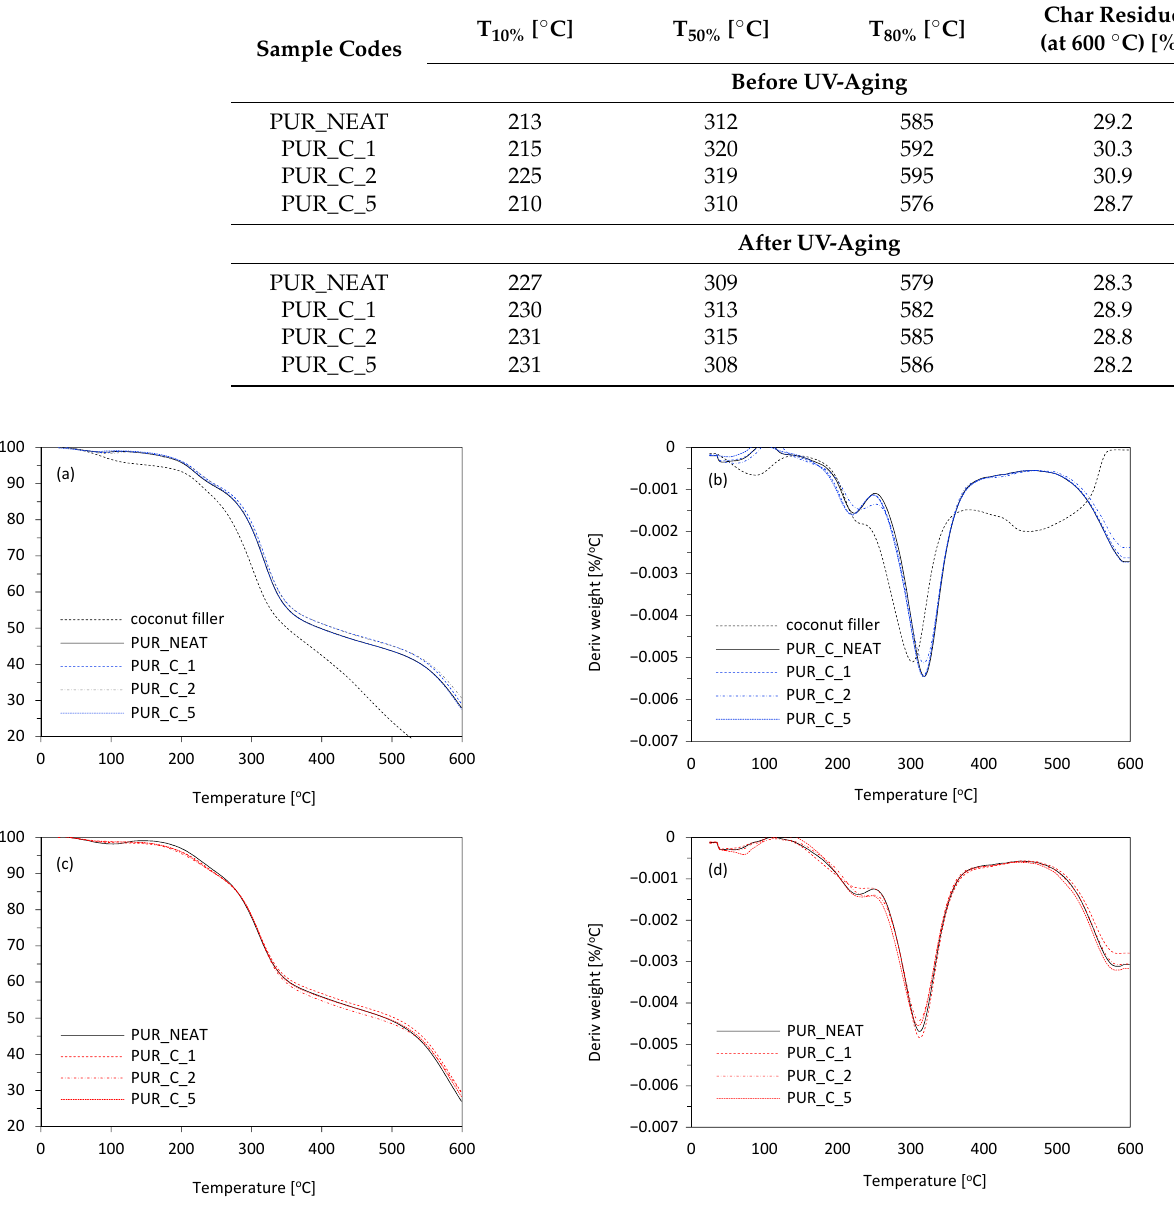
Figure 13. TGA results for PUR composites measured ( a , b ) before, and ( c , d ) after the UV-aging. In all cases, a three-stage decomposition of the PUR composites was observed. The first stage of decomposition (T max1 ) occurred in the range of 200–230 °C and referred to the moisture absorption of cellulosic filler [57–60] and decomposition of the urethane bond [57,58]. The second stage (T max2 ) of the PUR-composite decomposition occurred in the range of 300–350 °C, and should be assigned to the thermal pyrolysis of hard segments of PUR, which resulted in the formation of alcohol and isocyanate groups [61–63]. When compared with PUR_NEAT, T max2 increased on the addition of 1 and 2 wt % of coir-fiber filler—the value of T max2 increased from 312 °C (for PUR_NEAT) to 320 and 319 °C, respectively. Due to the more porous structure, the value of T max2 decreased slightly to 310 °C on the addition of 5 wt % of coir-fiber filler. The third stage of thermal decomposition of the PUR composites was mostly connected with the combustion of the composites, as well as thermal decomposition of the cellulosic derivatives hemicellulose and lignin [64,65]. When compared with PUR_NEAT, the PUR composites reinforced with 1 and 2 wt % of coir-fiber filler were more thermally stable—the value of T max3 increased from 585 °C (for PUR_NEAT) to 592 and 595 °C, respectively. The observed thermal-degradation behavior indicated that filler particles delayed the temperature of thermal decomposition by acting as a mass transport barrier and superior insulator to the volatile compounds, which were released during the thermal decomposition [66]. Besides, the thermal decomposition of PUR composites may be additionally reduced due to the higher cross-linking structure of the composites and the additional chemical bond between the functional groups of coir- fiber filler and isocyanate groups. The obtained results were in agreement with the results of the mass of char residue of the PUR composites obtained at 600 °C. Compared to PUR_NEAT, the mass of char residue increased from 29.2% to 30.3 and 30.9% for PUR_C_1 and PUR_C_2, respectively, and then decreased slightly to 28.7% for PUR_C_5. Based on this, it can be concluded that during the thermal-decomposition process, the filler particles could act as radical scavengers, while the higher cross-linking structure of the PUR